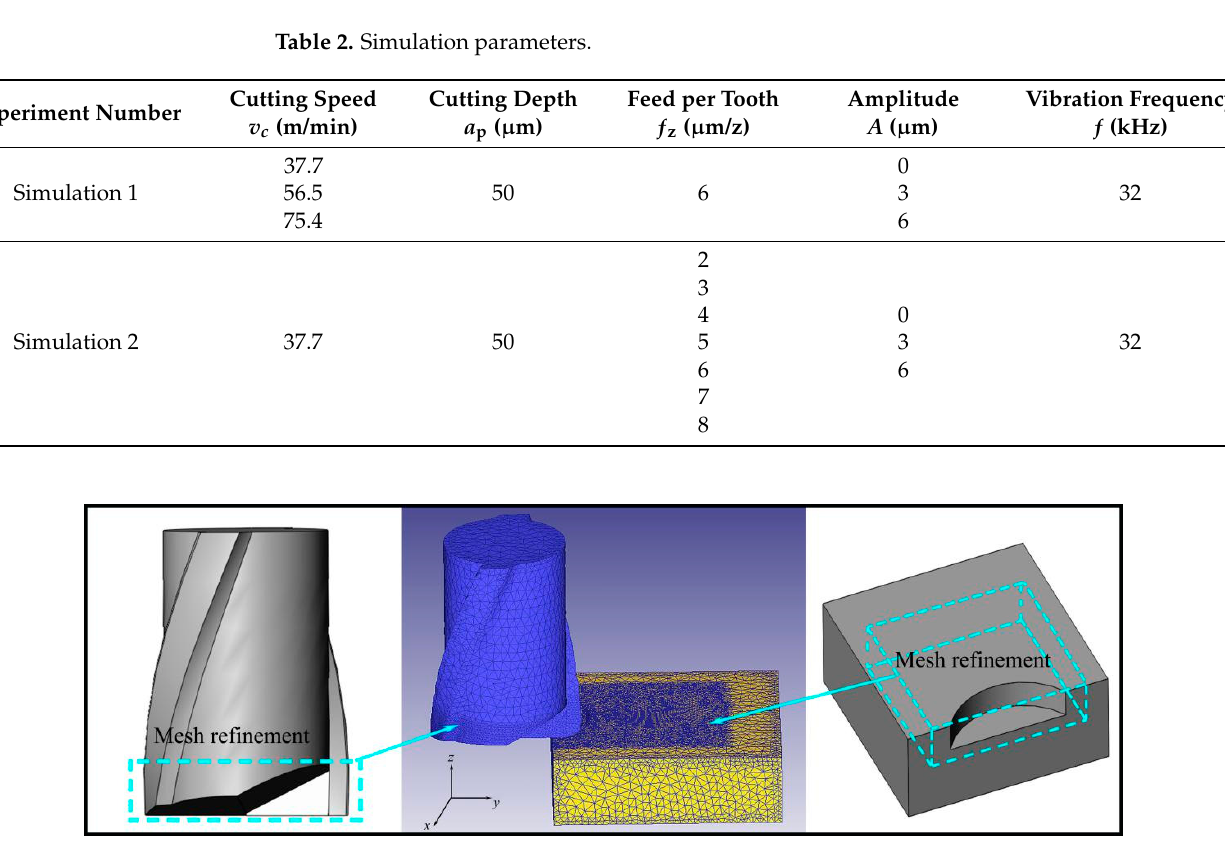
Figure 1. Simulation model and meshing.